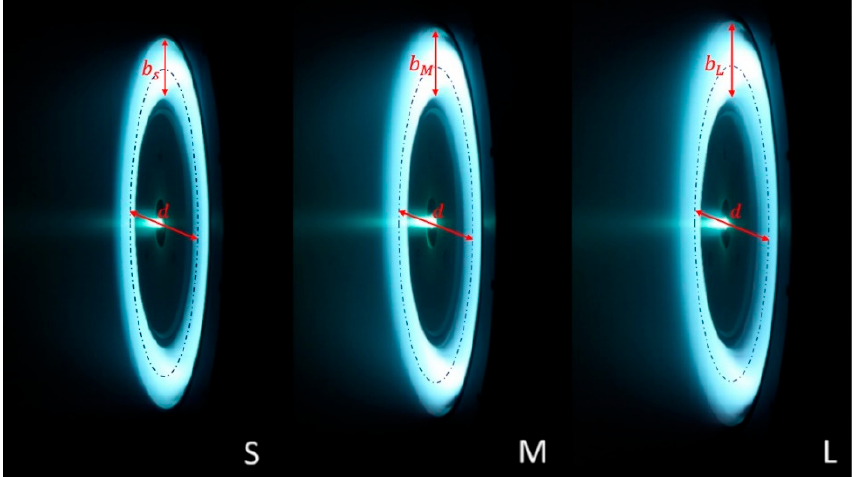
Figure 1. HT20k DM2 configurations: HT20k S ( left ), HT20k M ( middle ), and HT20k L ( right ) during firing.